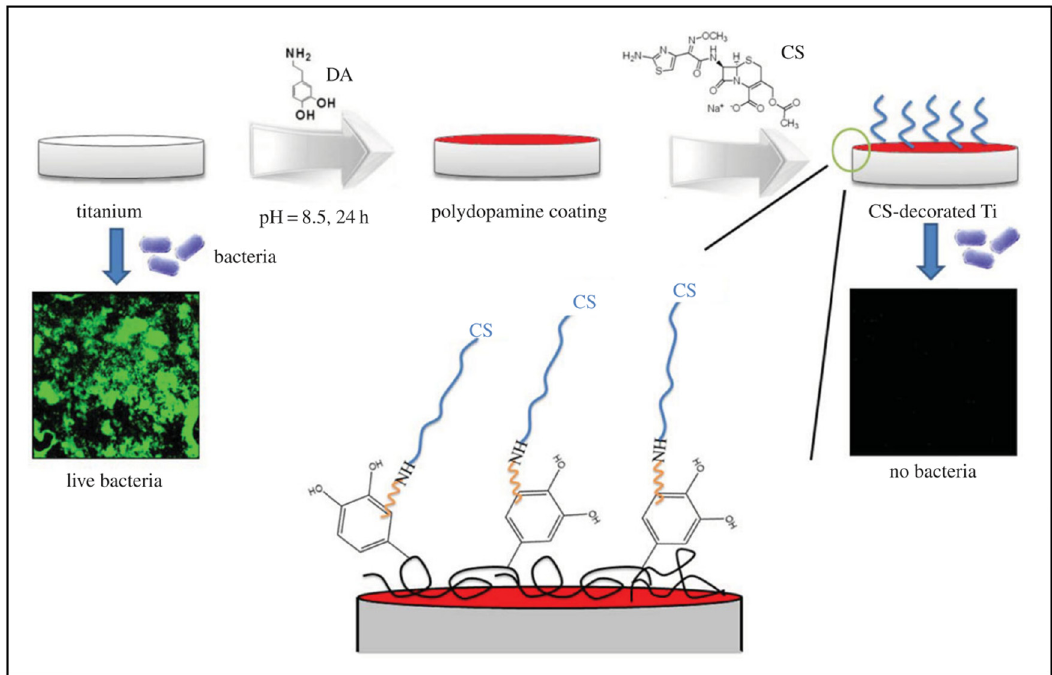
Figure 9: Schematic illustration of the SAM process, preparing, and analyzing antibacterial activity of cefotaxime sodium - decorated Ti by coating polydopamine ( PDA ) . The possible chemical structure, as well as the suggested reaction mechanism, is also shown [ 96 ] . Copyright 2014, Journal of the Royal Society